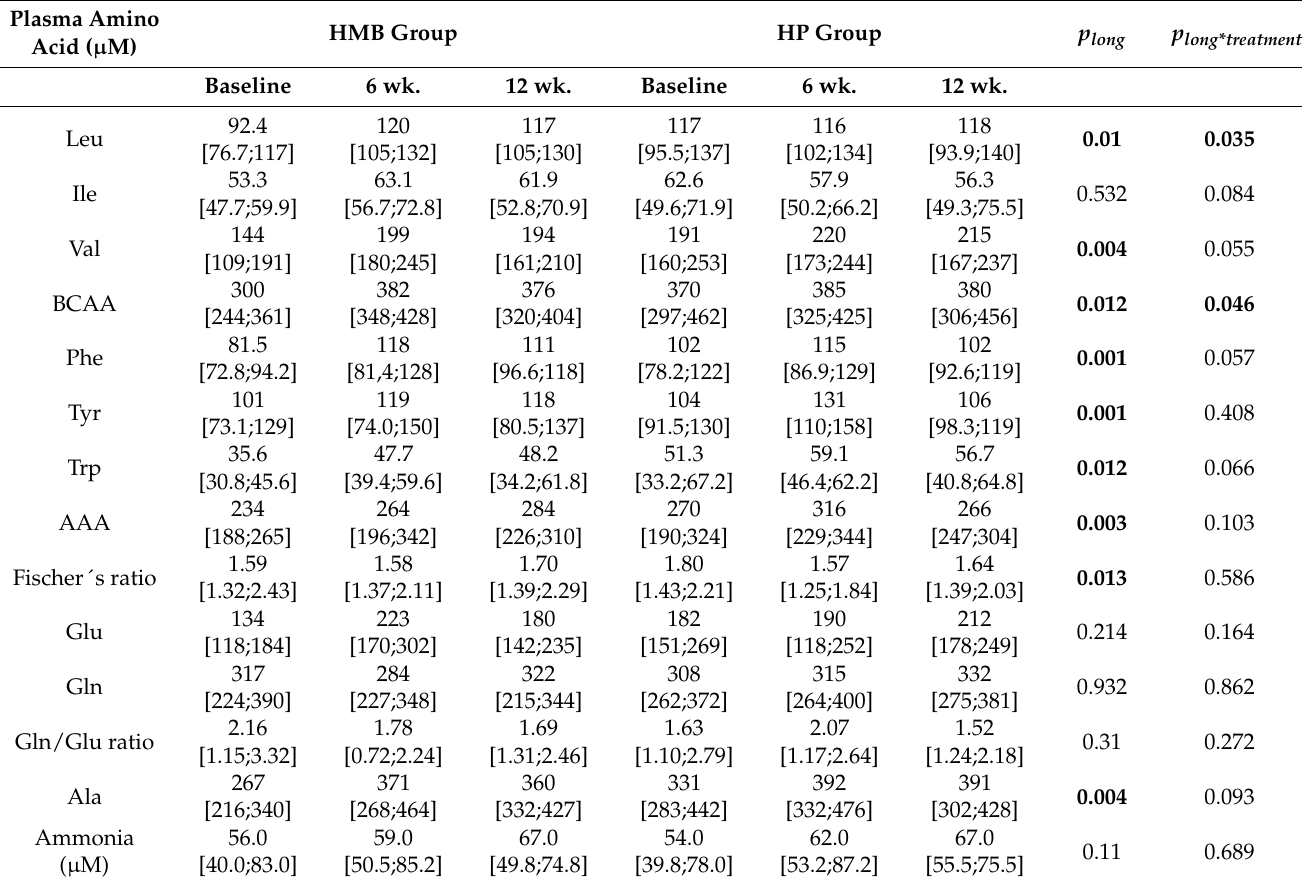
Table 3. Amino acid and ammonia levels for all subjects during follow-up according to treatment